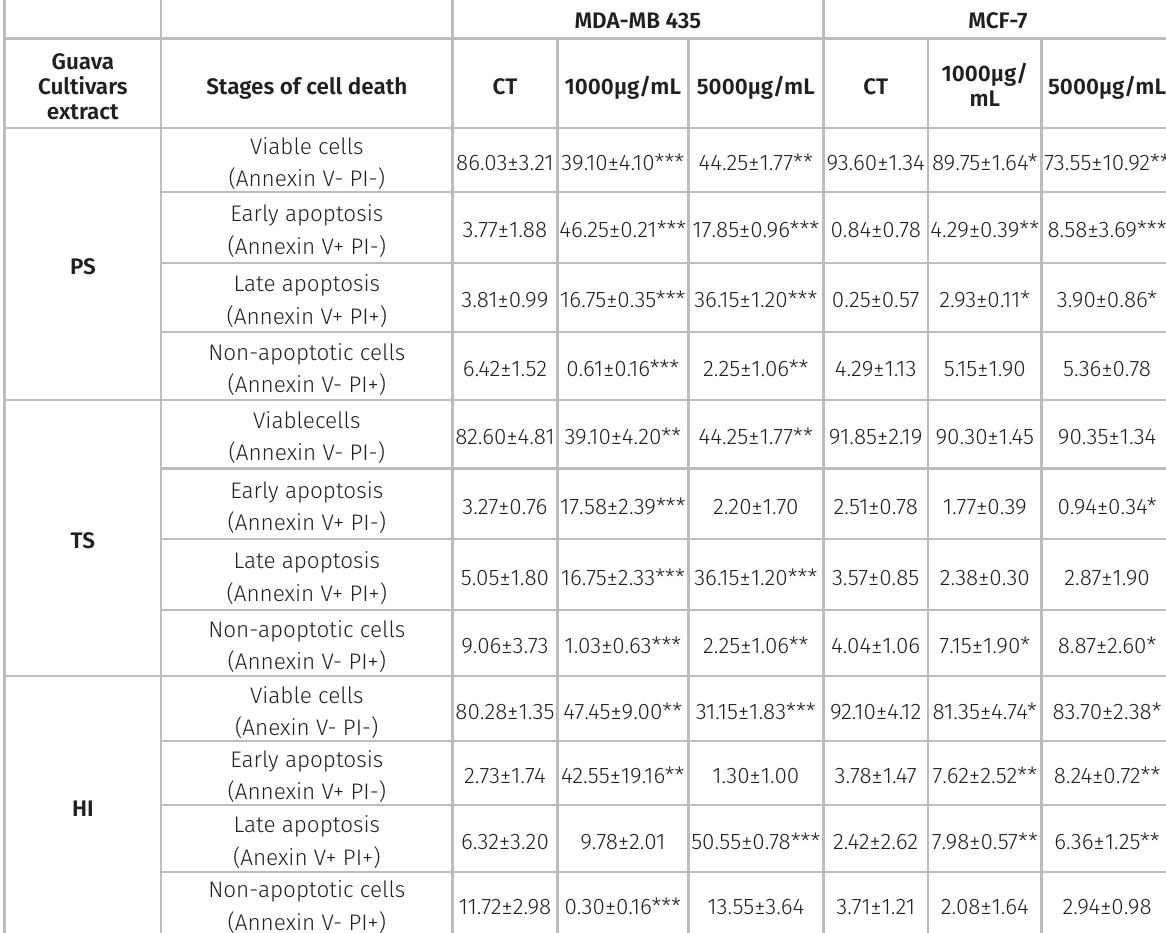
Table II. Effect of Pedro Sato(PS), Tsumori(TS) and Hitigio(HI) guava cultivars extracts on death process stages in MDA-MB-435 and MCF-7. Significant differences are indicated as *, **p<0.01,